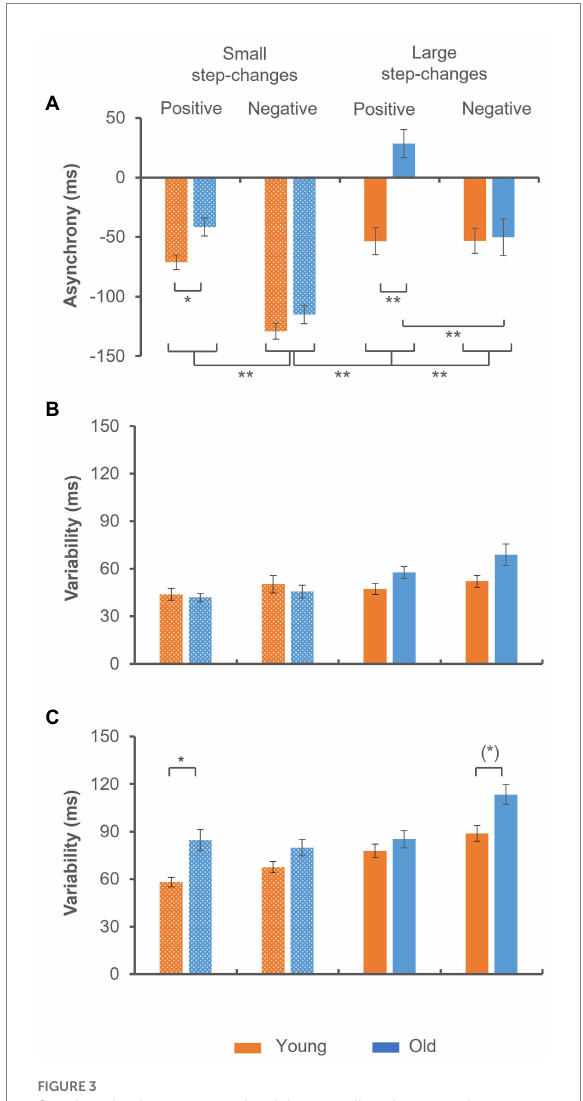
FIGURE 3 Synchronization accuracy in trials preceding the step-change. (A) Mean tap-to-tone asynchrony. Significant group differences emerged in trials preceding positive step-changes only. Prior to small step-changes the asynchrony was significantly smaller in the old group and changed to positive values prior to large step- changes. (B,C) Synchronization variability. While in trials with sub-second intervals no significant group-effect emerged (B) , variability was significantly larger in the old group in trials with supra-second intervals (C) . This was particularly evident in trials with small positive step-changes. A trend toward significantly larger variability in this group was found in trials with large negative step-changes. Error bars indicate the standard error of the mean (*) p ≤ 0.10; * p ≤ 0.05; ** p ≤